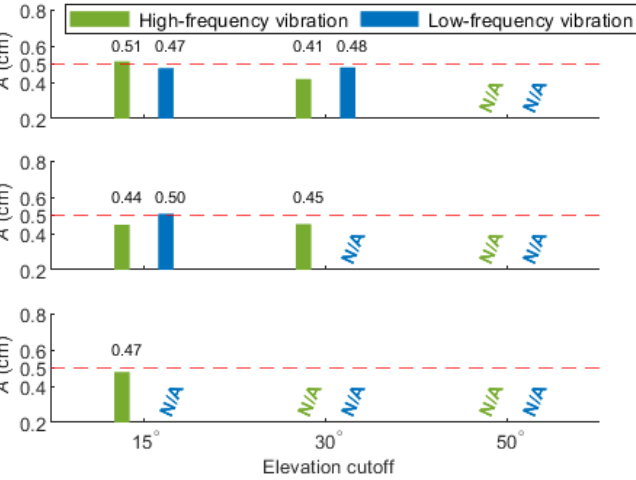
Figure 15. Amplitudes of the vibrational behaviors at levels of masking conditions. The GPS PPP is adopted during the process. The top, middle and bottom panels refer to the E, N and U directions, respectively.